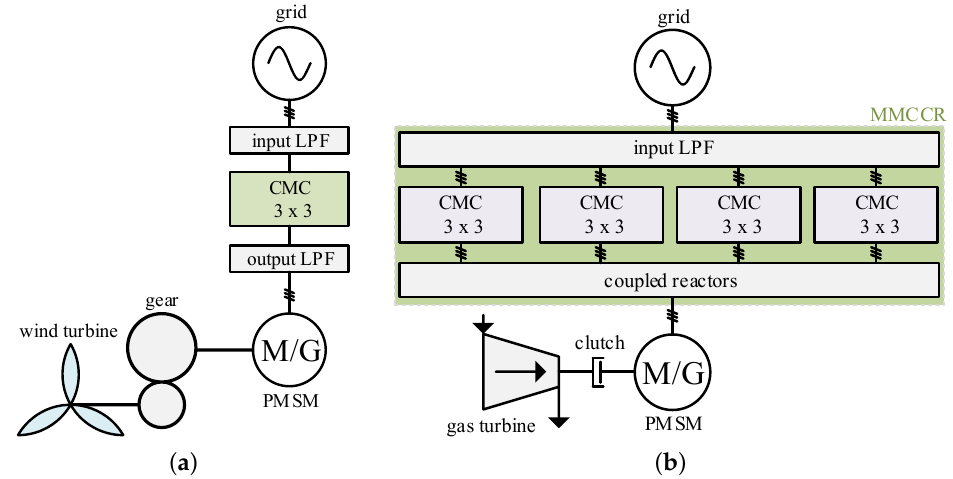
Figure 1. Examples of simplified application diagrams of turbines: ( a ) a wind turbine with a gear, ( b ) a gas turbine with a clutch. Conventional Matrix Converter (CMC) 3 × 3—conventional matrix converter with 3 inputs and 3 outputs, M/G—motor/generator, LPF—low-pass